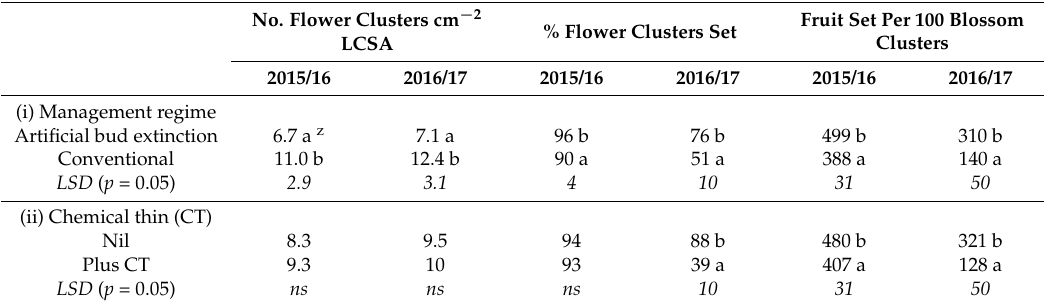
Table 3. Effect of management regime and thinning method on number of flower clusters and fruit set of ‘Alvina Gala’ (Trial 2). LCSA = limb cross-sectional area.